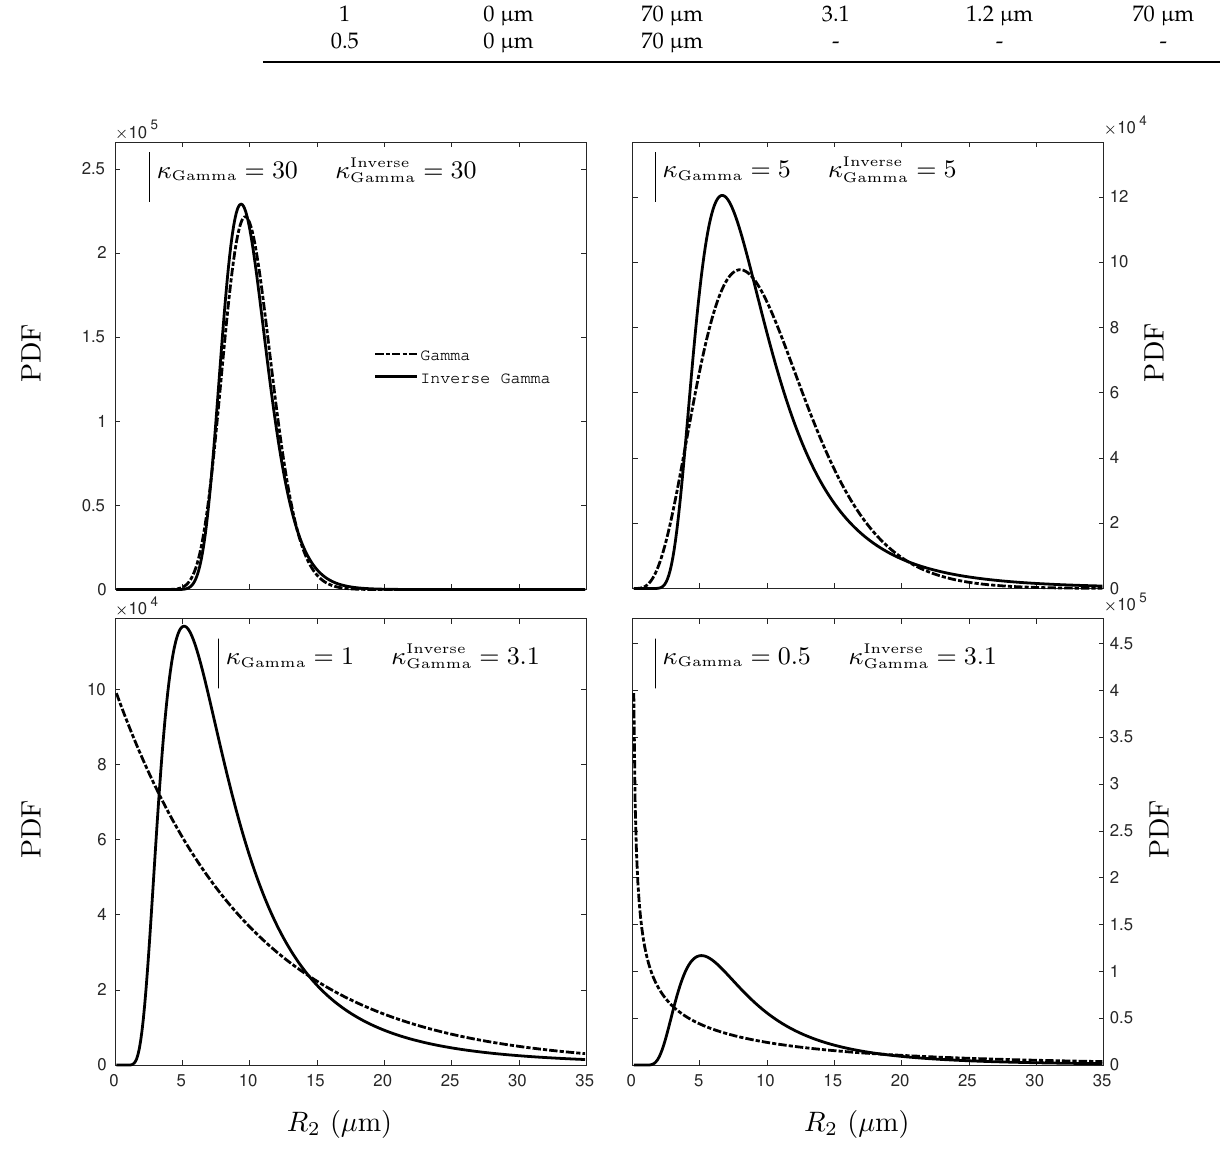
Figure 2: Initial Gamma and Inverse Gamma probability density functions (Eqs. (4.20) and (4.21)) versus the particle radius, Figure 2. Initial Gamma and Inverse Gamma probability density functions (Equations (32) and (33)) for various κ parameters. The β t =0 coefficient is computed via Eq. (4.28) such that the initial mean radius R 2 t =0 of the versus the particle radius, for various κ parameters. The β t = 0 coefficient is computed via Equation (40) polydisperse particles is R 2 t =0 = 10 µ m. t = 0 t = 0 = such that the initial mean radius R 2 of the polydisperse particles is R 2 10 µ